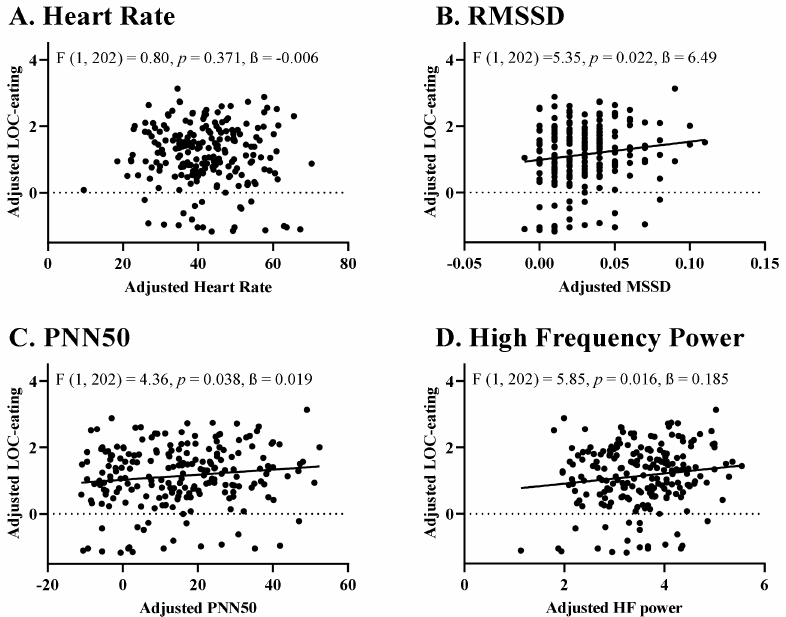
Figure 1. Associations of Pre-Meal Heart Rate Variability Metrics and Perceived LOC-Eating During a Laboratory Buffet Meal. ( A ) Pre-Meal Heart Rate and Perceptions of LOC-eating; ( B ) Pre-Meal RMSSD and Perceptions of LOC-eating; ( C ) Pre-Meal PNN50 and Perceptions of LOC-eating; ( D ) Pre- Meal High Frequency Power and Perceptions of LOC-eating. LOC-eating, loss-of-control eating in the past month; RMSSD, Root mean square of successive RR interval differences; PNN50, Percentage of successive RR intervals that differ by more than 50 ms; Log HF Power, logarithmic mean of the absolute power of the high-frequency band (0.15–0.4 Hz). Models were adjusted for sex assigned at birth (0 = Female, 1 = Male), race/ethnicity (0 = Non-Hispanic White, 1 = Other), report of LOC-eating in the prior month (0 = denied, 1 = endorsed), lean mass (kg), percentage body fat mass, and age. When the analyzed data were restricted only to participants who did not report recent LOC-eating, none of the HRV metrics were significantly associated with LOC-eating severity (ps = 0.148–0.989), total energy intake (ps = 0.270–627), or percentage intake